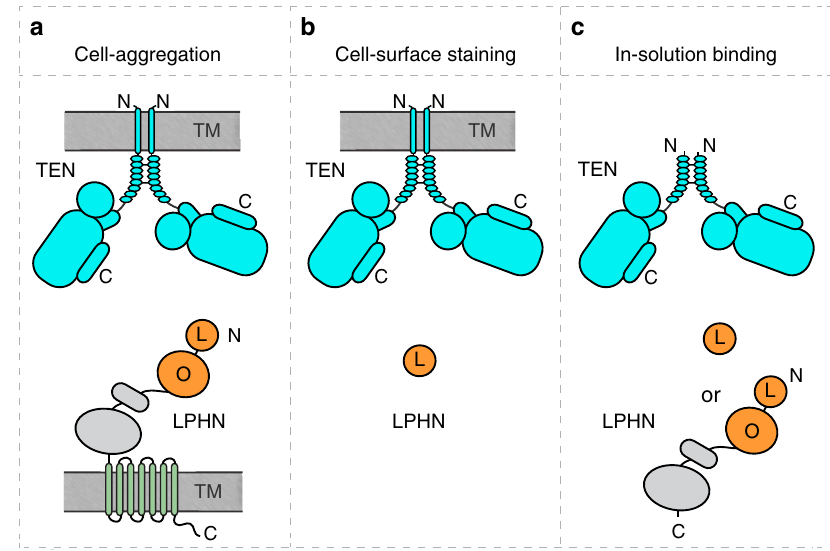
Fig. 4 Experimental setups to investigate the effect of various restraints. Three experimental setups with decreasing restraints on the docking geometry of LPHN3 and TEN2 during their interaction. a Setup for trans-cellular interaction of full-length TEN2 with full-length LPHN3 in cell-aggregation experiments. Both proteins are anchored on the cell-membranes and their mobility is restricted by their lateral diffusion within the membrane. b Setup for cis-like-interaction of full-length TEN2 and soluble biotinylated Lec domain of LPHN3 in either fl ow cytometry or cell-surface staining experiments. TEN2 is anchored on the cell-membrane, but the Lec domain of LPHN3 freely rotates in solution. c Setup for in-solution experiments for cis-like-interaction of soluble TEN2 and soluble LPHN3 in the absence of any